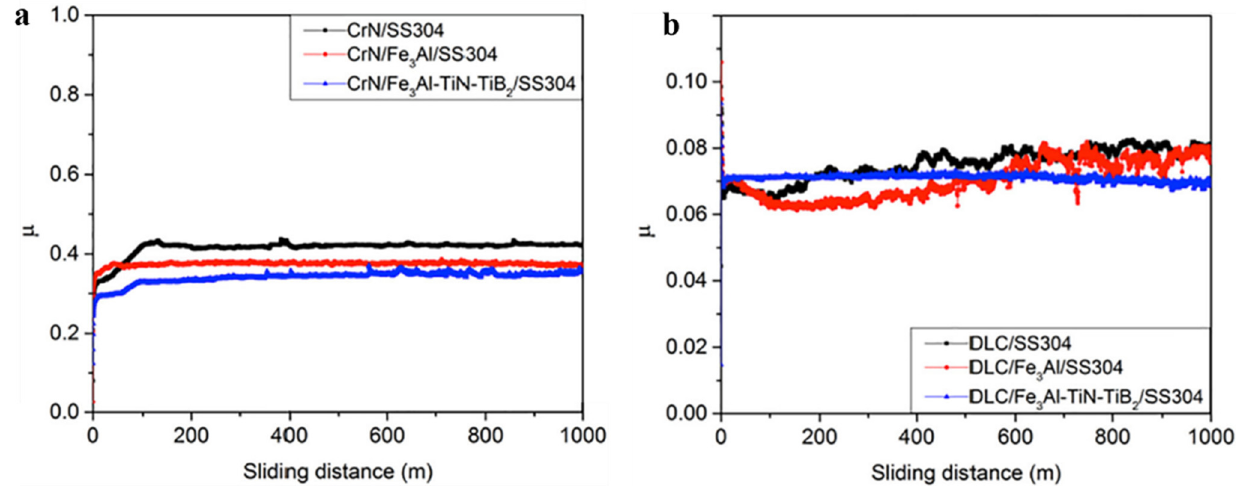
Figure 8. The COF of ( a ) CrN-based and ( b ) DLC-based PVD coating and HVOF-PVD duplex